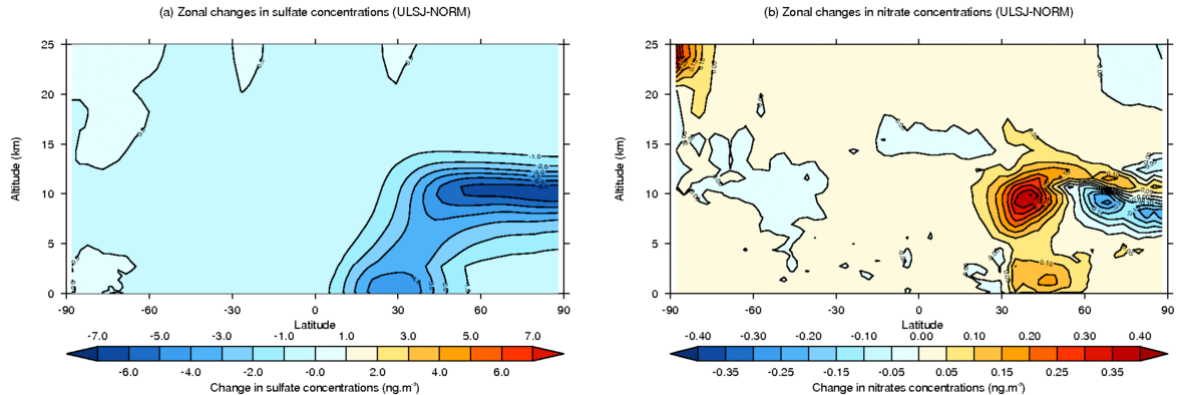
Figure 5. Simulated differences in zonal annual mean sulfate (a) and nitrate (b) concentrations from the use of ULSJ fuel relative to standard fuel (ULSJ–NORM).